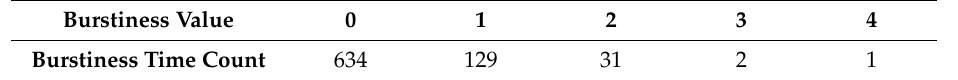
Table 1. Burstiness distribution list (BDL) of a link after finishing the measure link quality (MLQ) period.